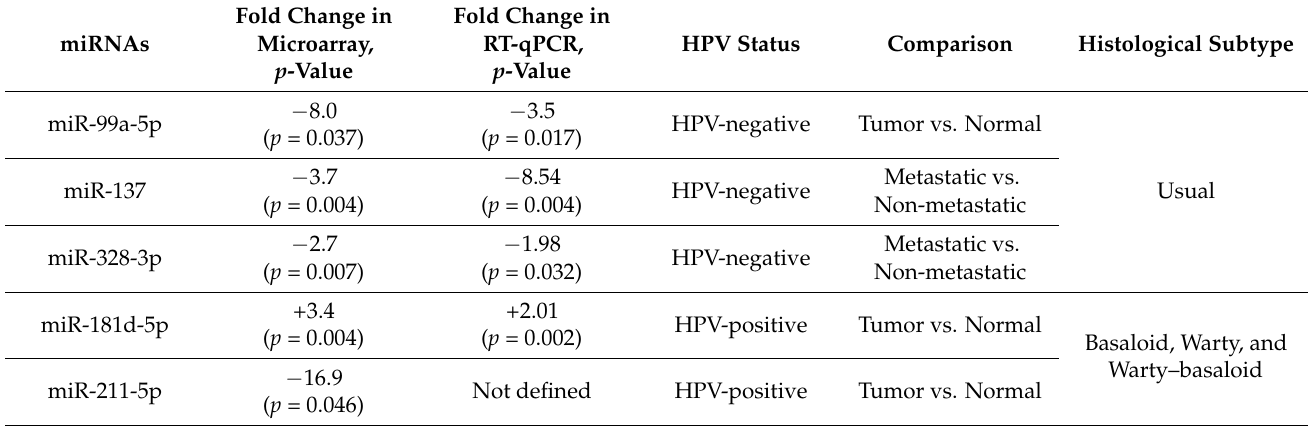
Table 2. Summary of miRNAs validated by microarray and RT-qPCR in different histological